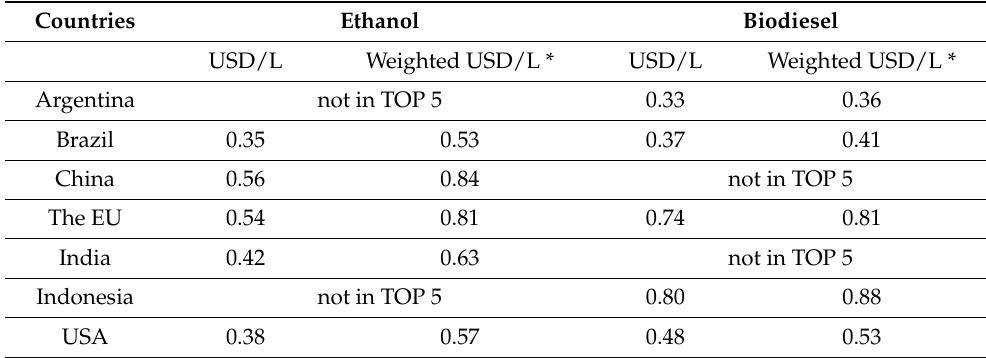
Table 1. Ethanol and biodiesel producer prices of the main producers in 2020. Countries Ethanol Biodiesel USD/L Weighted USD/L * USD/L Weighted USD/L * Argentina not in TOP 5 0.33 0.36